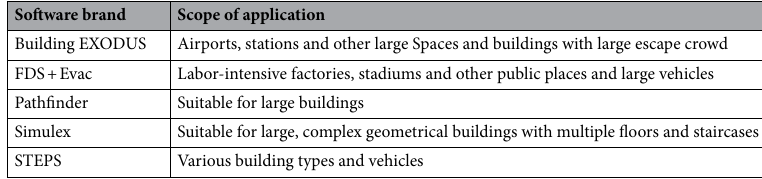
Table 3. Common evacuation simulation software and its applicable scope.